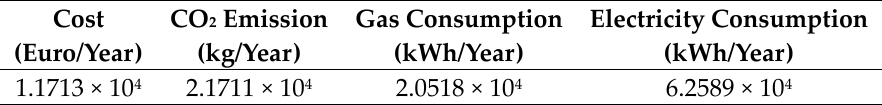
Table 1. Energy consumption only supply by net.